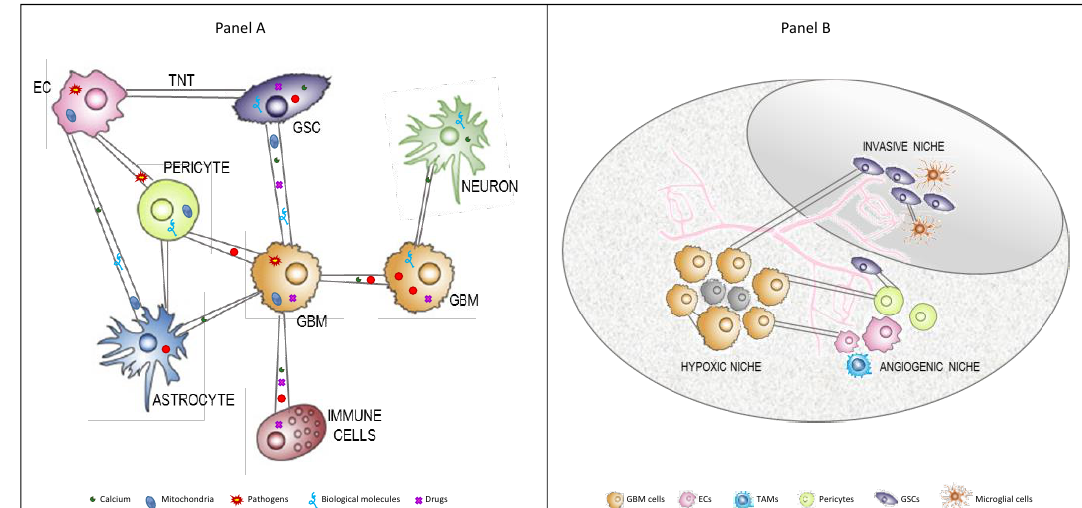
Figure 2. TNTs between cells composing the GBM TME. ( A ) TNTs are long membranous open-ended channels connecting cancer cells between them or with other cells composing the TME. They are dynamic and sensitive structures of different lengths and thicknesses able to allow for the interchange of organelles, vesicles, macromolecules, and pathogens between connected cells. ( B ) GBM and GSCs are embedded in a heterogeneous TME, which is composed of diverse stromal cells, including vascular cells, infiltrating and resident immune cells, and other non-neoplastic glial cell types, but they are also compartmentalized in distinct brain areas, called niches. These niches regulate metabolic needs, immune surveillance, survival, invasion, and the progression of GBM. TNTs are able to physically connect these cells even if located in different niches. Abbreviations: TNT, tunneling nanotube; TME, tumor microenvironment; EC, endothelial cells; GSCs, glioblastoma stem cells; GBM, glioblastoma; TAMs, tumor-associated